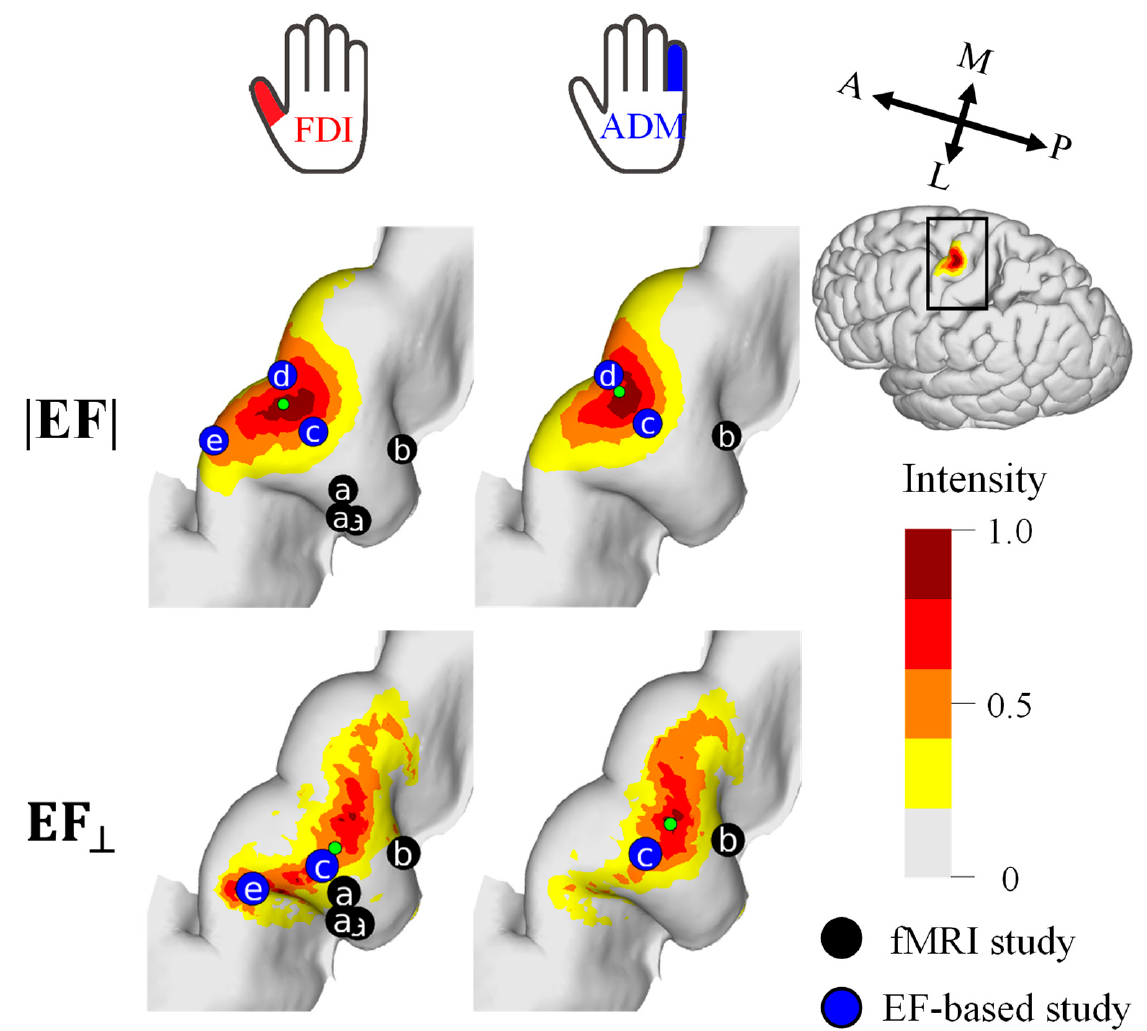
Figure 4. Group-level hotspot ( n = 11) of the FDI and ADM muscles based on the electric field strength (|EF|) and normal component to the wall (EF ⊥ ). Hotspots of previous fMRI studies (a [38] and b [16]) and EF-based studies (c [16], d [21], e [17]) are shown for comparison. Five and three samples were used for mapping with the |EF| and EF ⊥ , respectively .